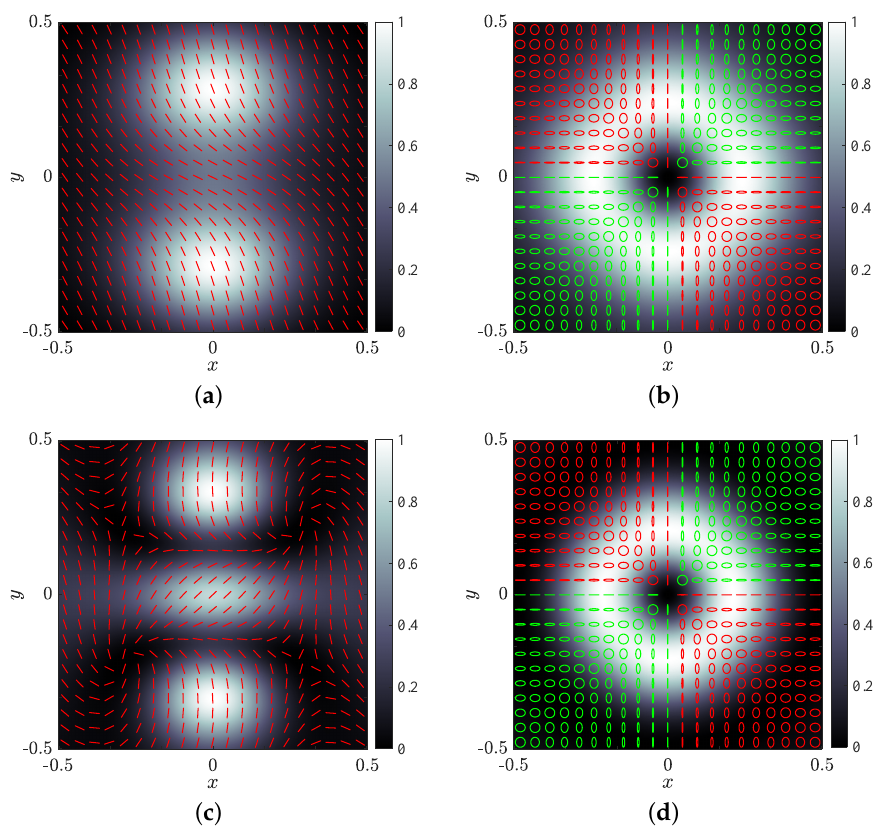
Figure 3. Polarization pattern and intensity profile normalized to its maximum (color scale) for the beams generated from the field in Equation (16) for ( a ) q = 0; ( b ) q = 1; ( c ) q = 2; and ( d ) q = 3. Green for right-handed elliptical polarization and red for left-handed and linear